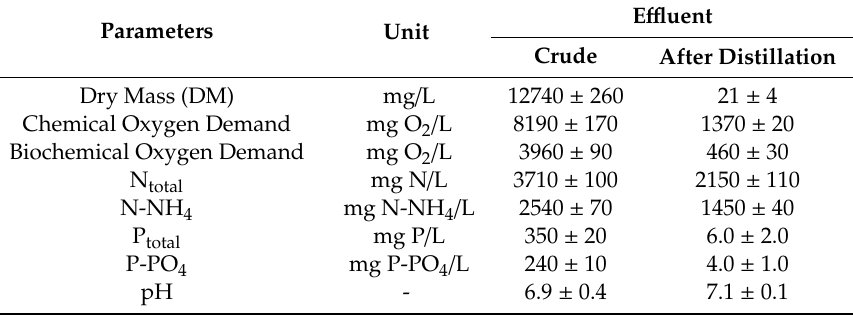
Table 3. Characteristics of the post-fermentation